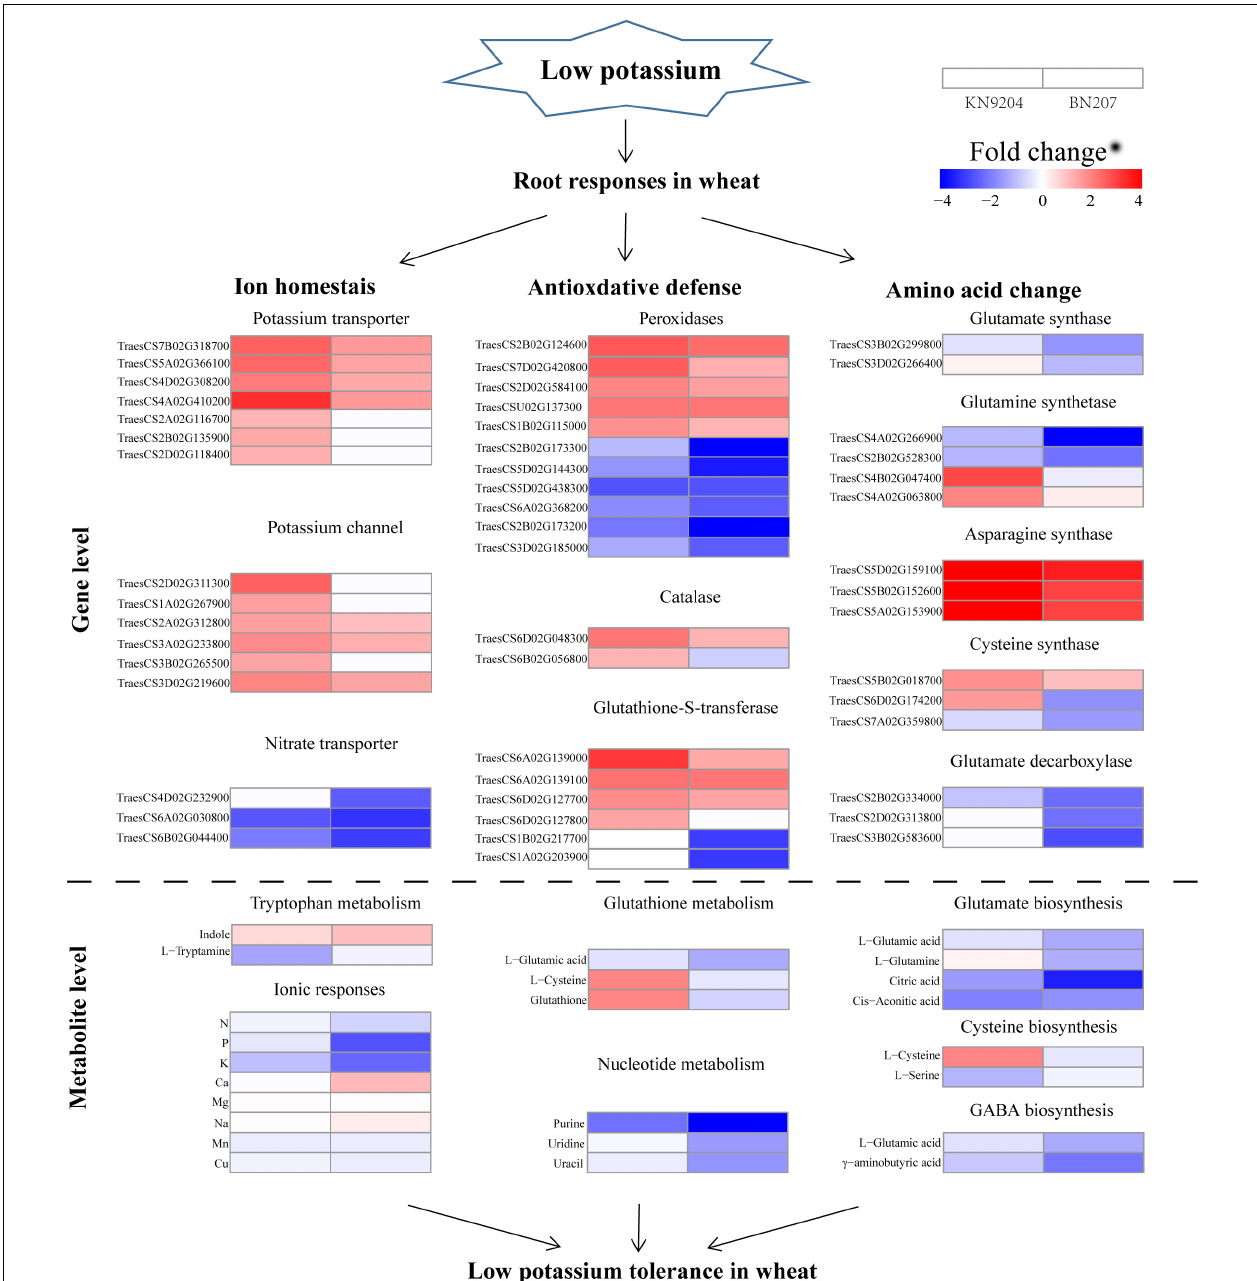
FIGURE 4 | Comparison of the transcriptomic and metabolomic profiles of the KN9204 and BN207 roots after the low-K stress treatment. Genes and metabolites involved in metabolic processes are classified into three main categories: ion homeostasis, antioxidative defense, and amino acid changes. Blue indicates decreased gene expression and metabolite contents, whereas red indicates increased gene expression and metabolite